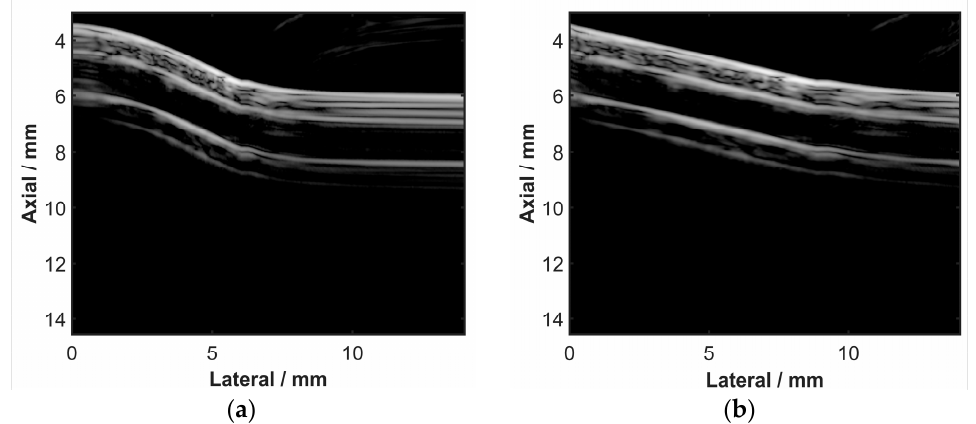
Figure 13. The detected B mode images of the fl ow phantom: ( a ) the original image without motion compensation and ( b ) the compensated image.